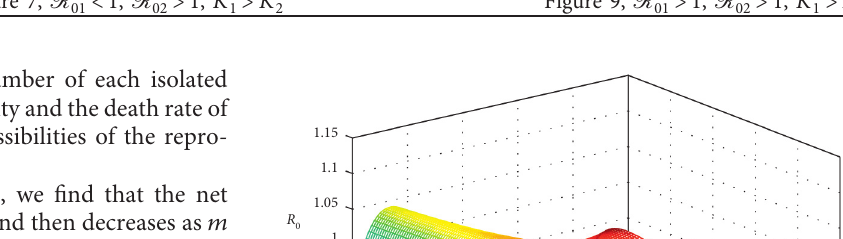
> 1, R > 1, K < K 01 02 1 2 > 1, R > 1, K > K 01 02 1 2